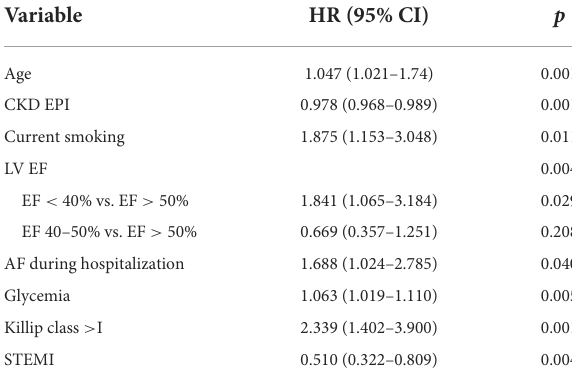
TABLE 3 Cox regression of factors associated with mortality after myocardial infarction.